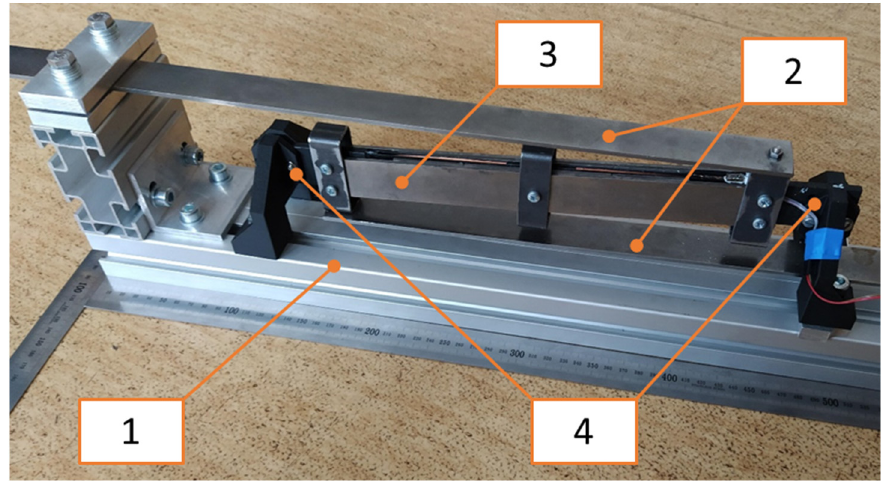
Figure 5. Design of proposed kinetic energy harvester.